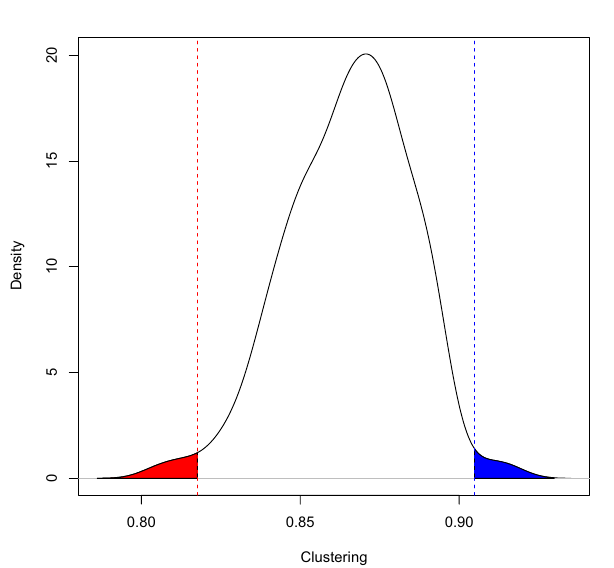
Figure 2. Daytime exposure to other social strata and segregation. Panel ( a ) shows the relationship between own income and average income at the daytime tower. Exposure to other socioeconomic groups is measured as the absolute deviation from this regression line. Panel ( b ) shows the distribution of exposure and the marginal effect of income differences on total communication intensity as a function of exposure.